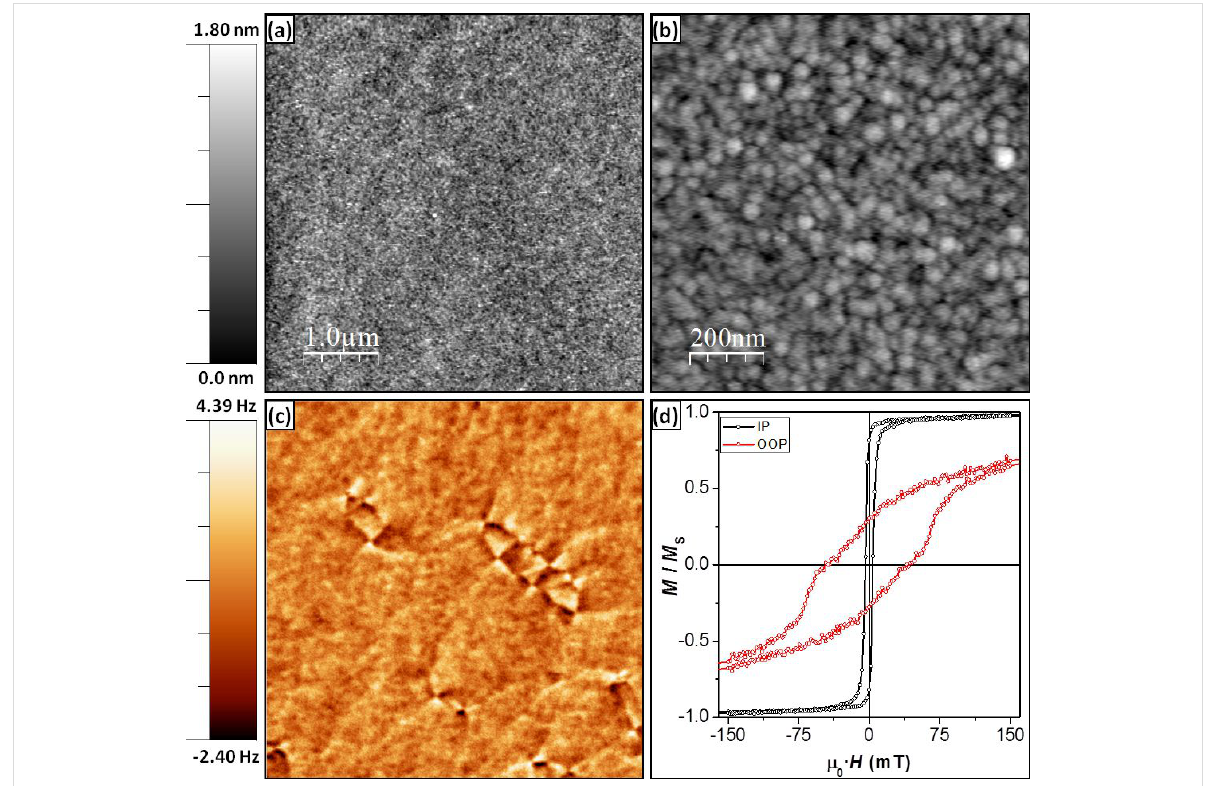
Figure 1: (a) (5 × 5) μ m 2 and (b) (750 × 750) nm 2 topographic images of a 20 nm thick Co layer grown onto a silicon substrate under the conditions used for coating the tips. (c) (5 × 5) μ m 2 MFM image of the same sample, showing a predominant IP magnetization with the presence of cross-tie domain walls. (d) VSM hysteresis loops show the preference for the magnetization to remain IP. Note: (a) & (c) were recorded simultaneously using a custom-made tip with a 20 nm Co coating on one side, whereas (b) was measured using a commercial AFM